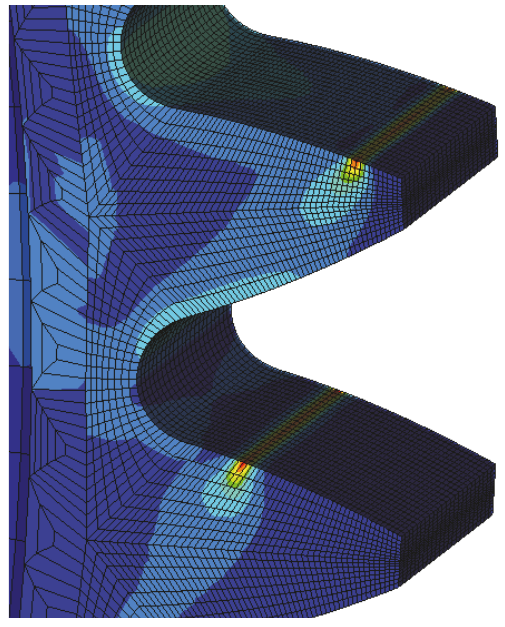
Figure 2: Example of stress distribution estimated by nonlinear FE simulation for the lightweight gear shown in Figure 1(b) in a given